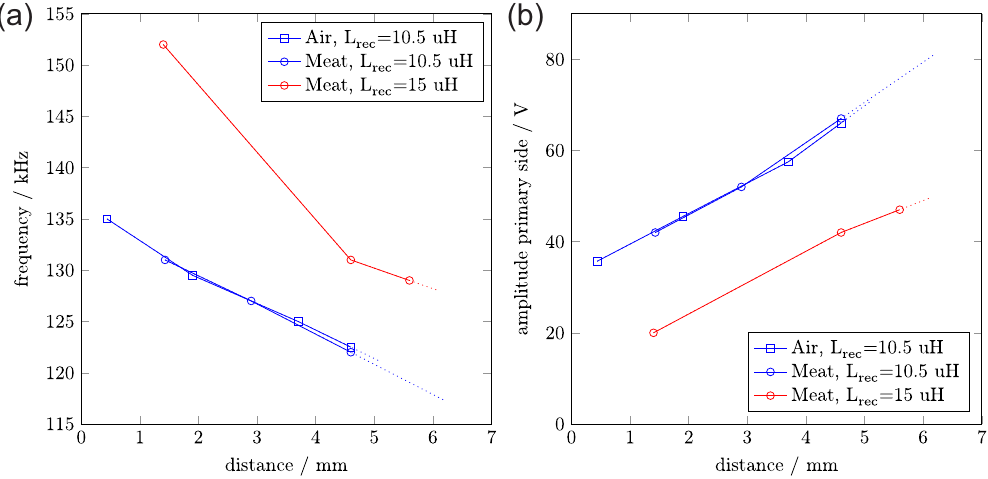
Figure 4. ( a ) wireless operation distances and according frequencies and ( b ) primary voltages (shown for two different coils and 100 mW DC transferred